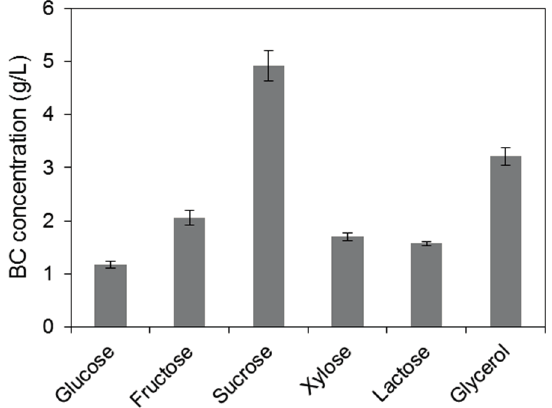
Figure 1. Bacterial cellulose production achieved when various commercial sugars and crude glycerol were used in shake flask fermentations.